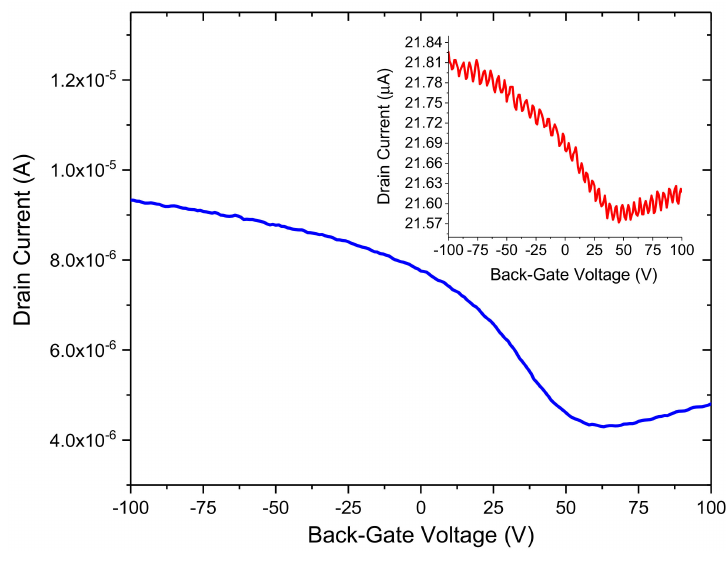
Figure 4. Annealed I D –V G curve of a CVD graphene FET and its corresponding I D –V G (inset) before annealing, both at V D = 100